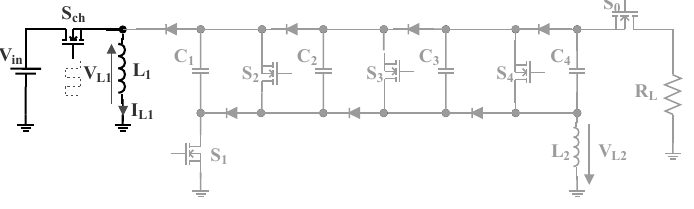
Figure 3. Phase 1 (A): charging of the